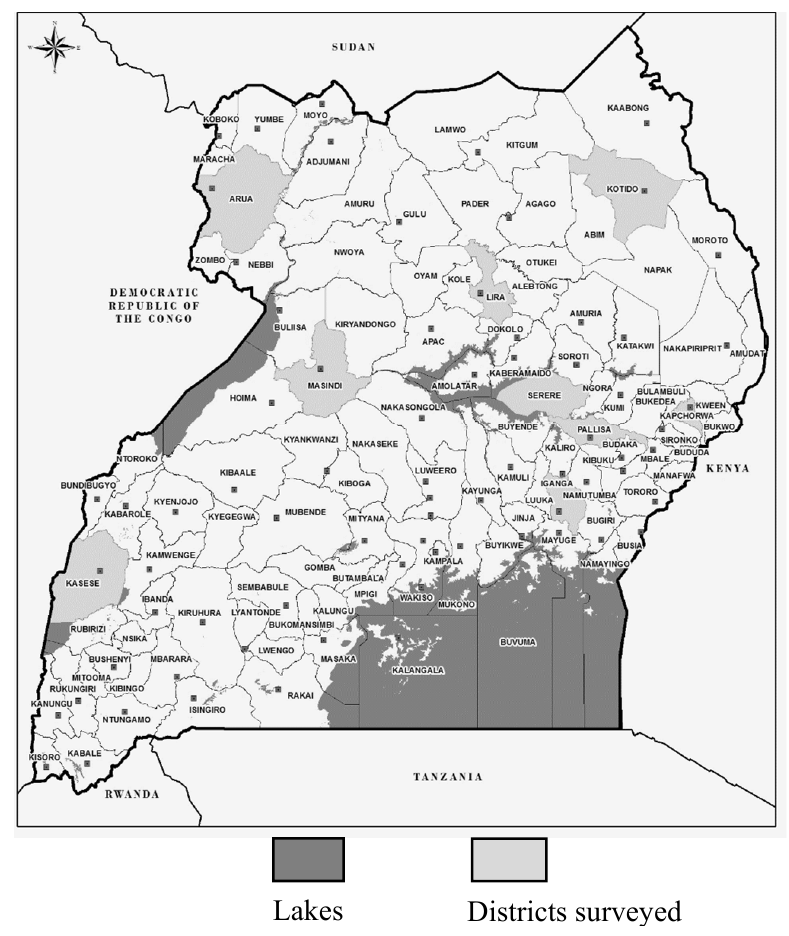
Figure 1. Map of Uganda, showing the nine districts surveyed (intermediate shading): Lira, Kotido, Serere, Arua, Masindi, Kapchorwa, Kasese, Iganga, and Pallisa.